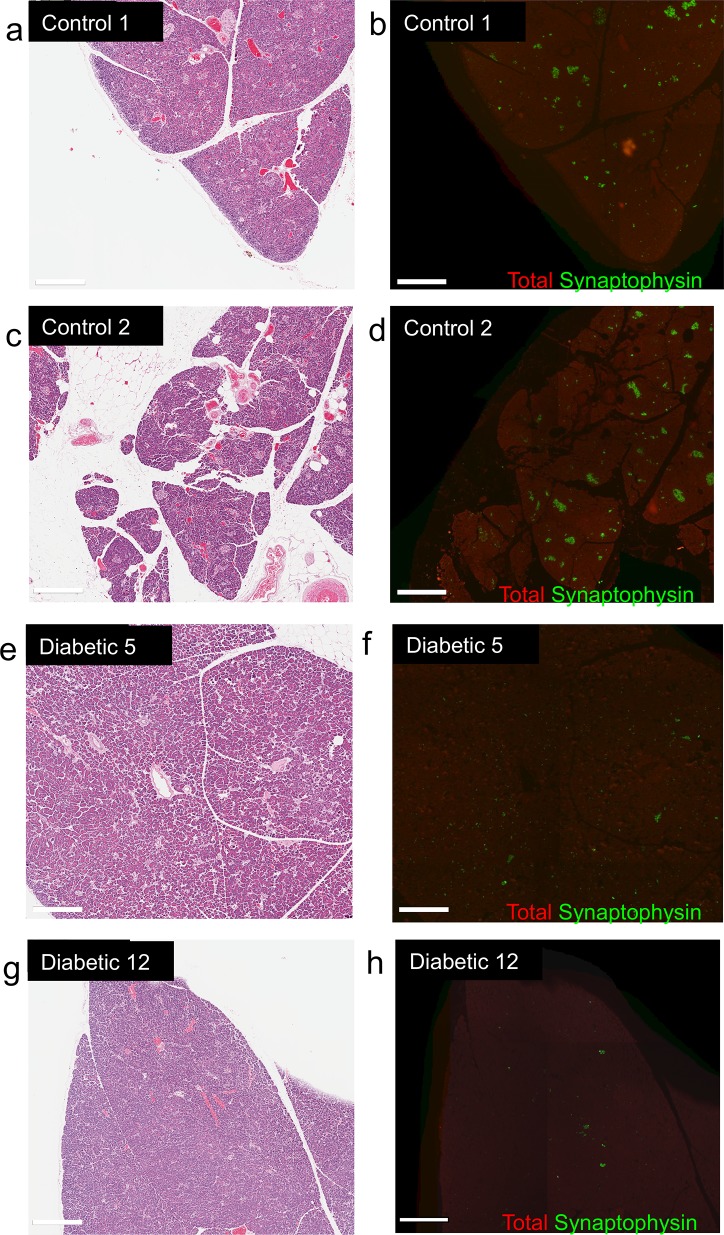
Characteristic histopathology of control and diabetic pancreata.Staining with H&E (left panels) or immunostaining (right panels) for total pancreas (red) and synaptophysin (green) of control (a-d) and diabetic (e-h) pancreata.